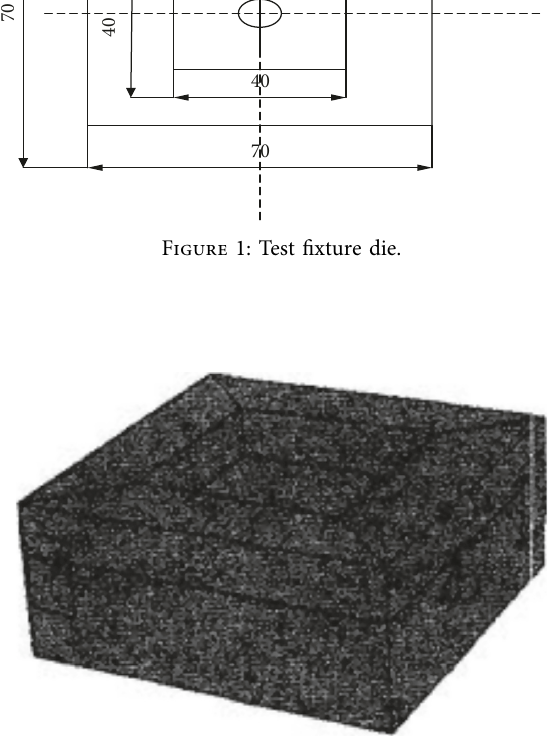
Figure 2: Forming die.